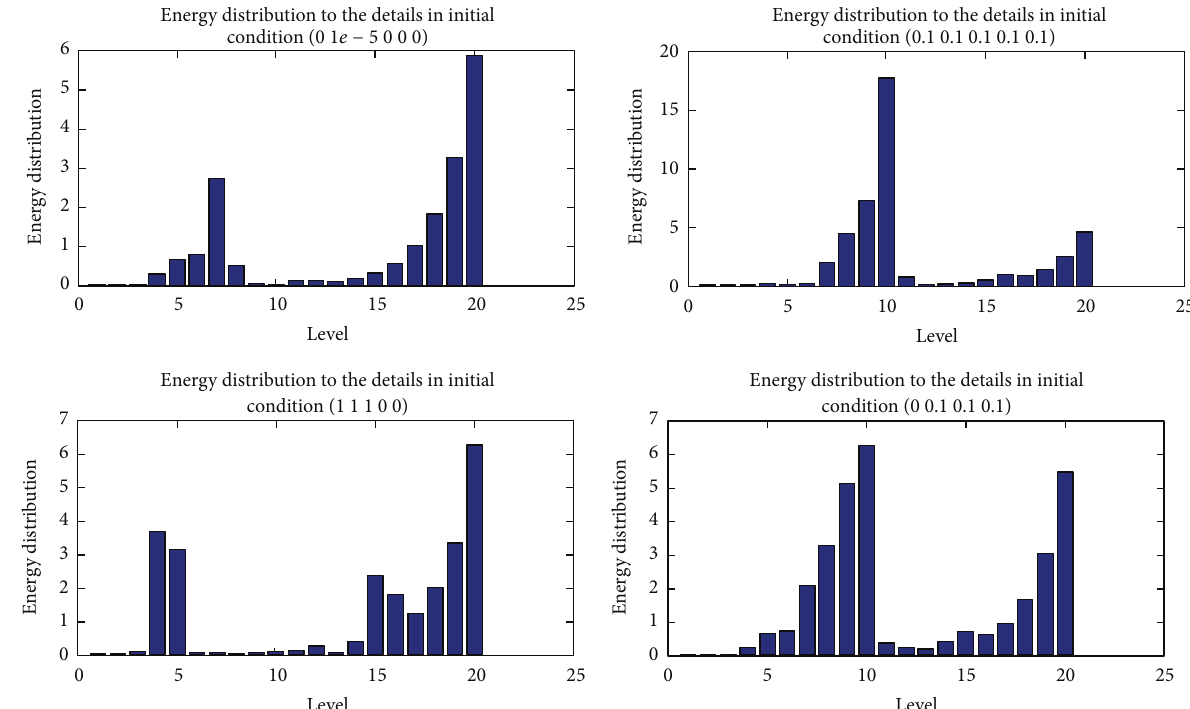
Figure 8: Energy distributions in different initial condition of the chaotic